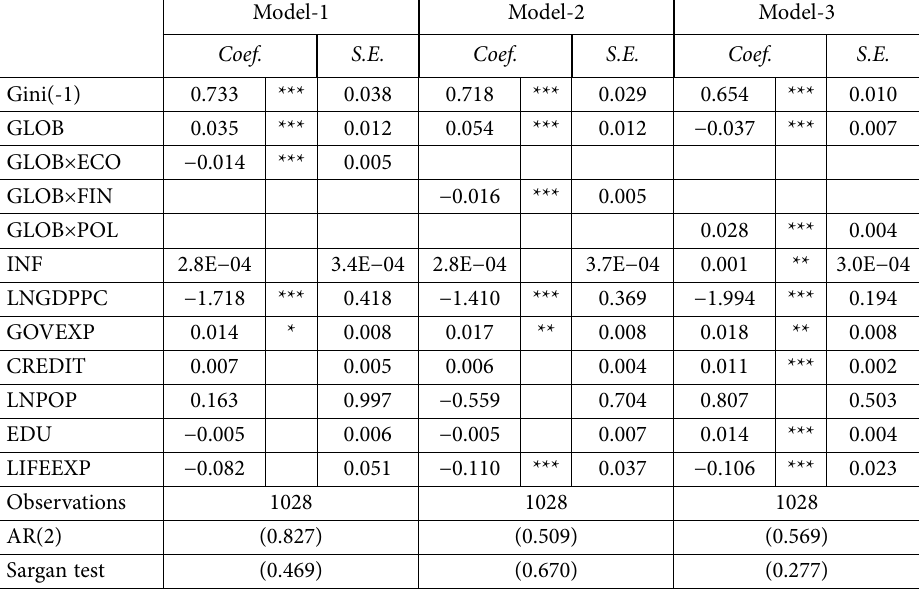
Table 10. Inequality, globalization, and country risk (low-income